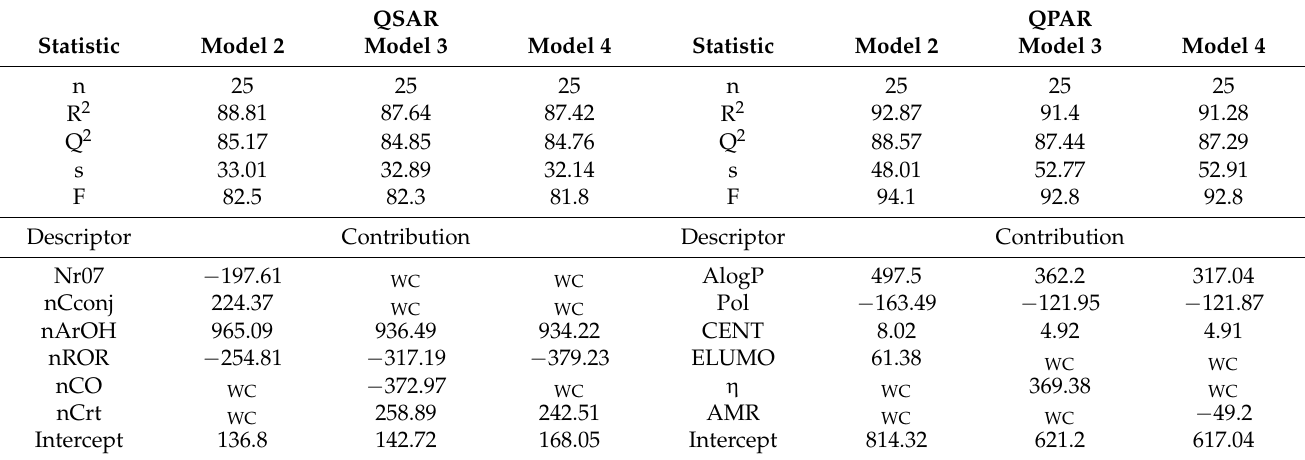
Table 2. Summary of statistics of QSAR and QPAR models obtain by genetic algorithm.